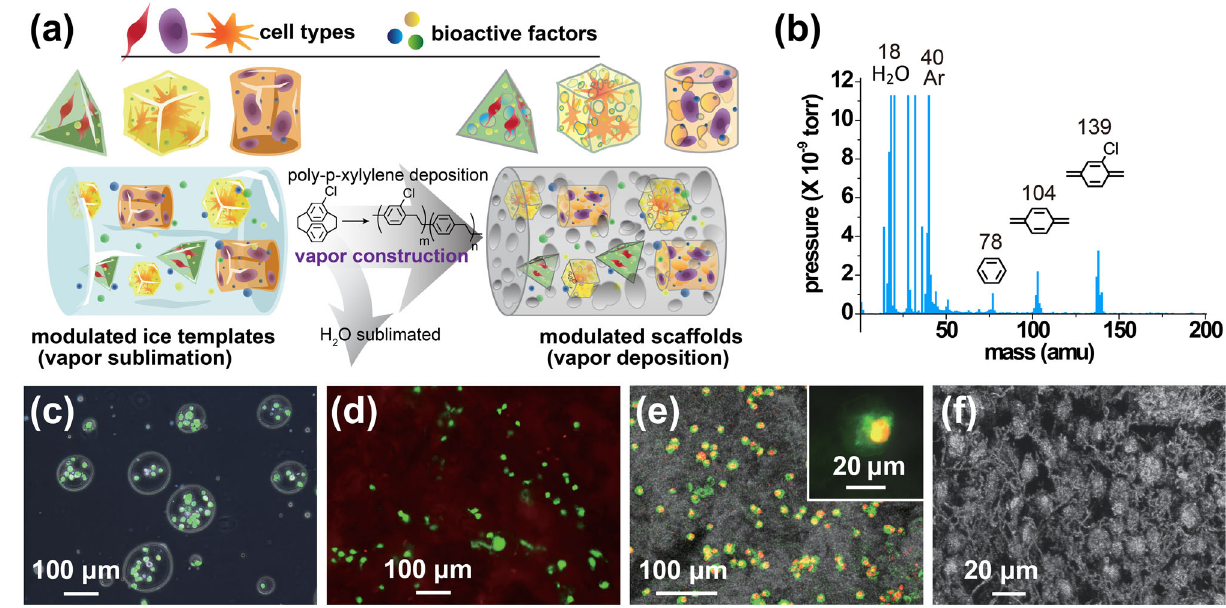
Fig. 1 Fabrication of cell-laden and multifunctional scaffold modules. a Schematic illustration of vapor-phase sublimation and deposition fabrication process. Iced template modules with de fi ned internal composition and outer architecture were formed through discrete module assembly and resulted in a continuous fi nal modulated construct by subsequent vapor deposition. b The analysis of vapor composition by real-time mass spectrometry during the fabrication process shows the presence of sublimated water vapor at 18 amu and the deposited quinodimethane monomers at 104 amu and 139 amu. c An overlaid image of LIVE/DEAD-stained hASCs prepared in an oil-in-water system. Veri fi cation of hASCs within a fabricated module after vapor-phase deposition process by d LIVE/DEAD staining, e fl uorescence labeling with Alexa Fluor ® 488-conjugated phalloidin to stain the cytoskeleton (green) and propidium iodide to stain the nucleus (red); a high-resolution and magni fi ed image of a stained cell was shown in the inset, and f SEM dissection image. Each experiment was repeated three times independently ( n = 3) with similar